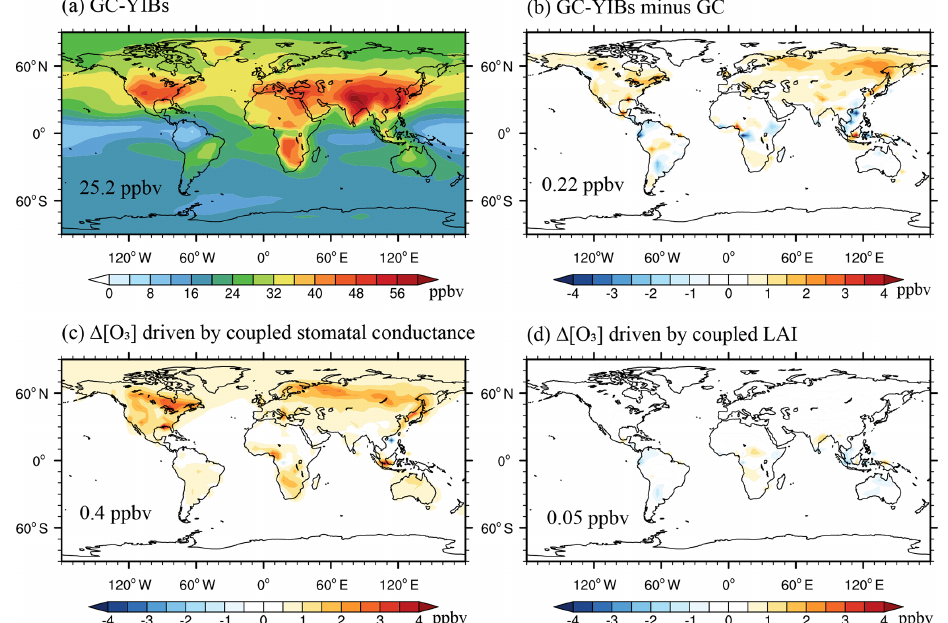
Figure 4. Simulated annual surface [O 3 ] from online GC-YIBs model (a) and its changes (b–d) relative to offline simulations. Changes of [O 3 ] are caused by (b) jointly coupled LAI and stomatal conductance (Online_ALL – Offline), (c) coupled stomatal conductance alone (Online_ALL – Online_LAI), and (d) coupled LAI alone (Online_ALL – Online_GS). Global area-weighted [O 3 ] or (cid:49) [O 3 ] are shown in the